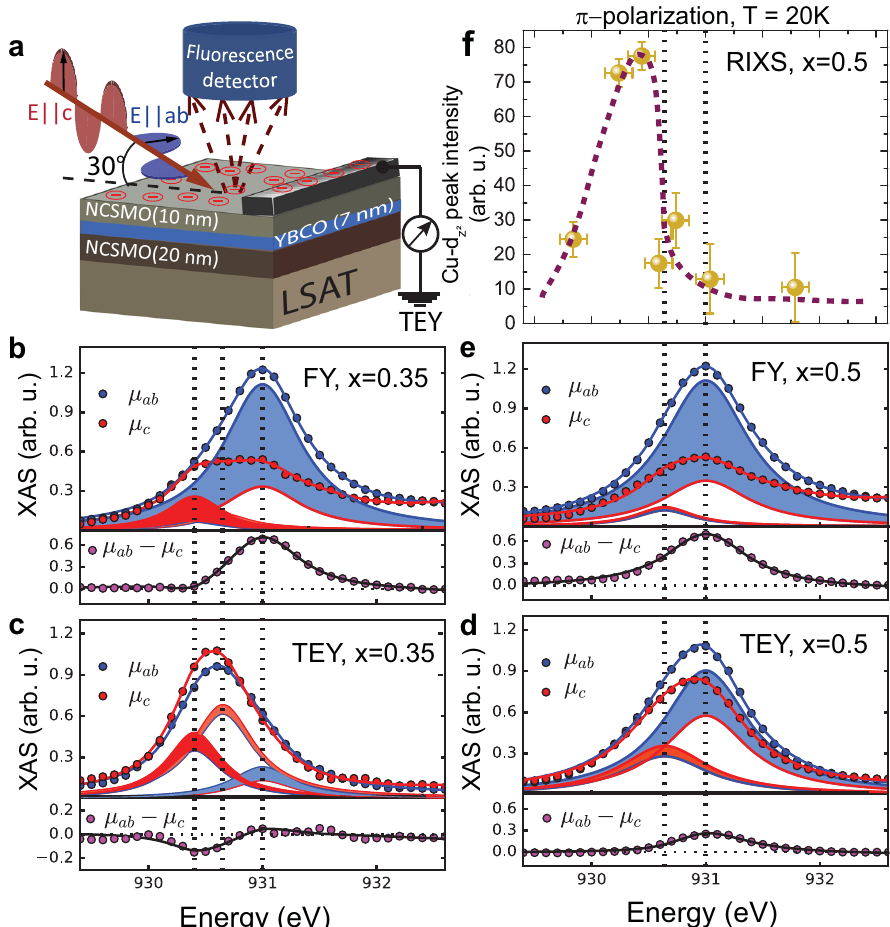
Fig. 4 Charge transfer and orbital reconstruction probed with XAS. a Schematic of the setup for measuring XAS in FY and TEY modes. b – e Comparison of the XAS spectra at the Cu L 3 -edge at 20 K and their X-ray linear dichroism (XLD) for NYN trilayers with x = 0.35 and x = 0.5. The FY spectra in ( b ) and ( e ) represent the response of all Cu ions whereas the TEY spectra in ( c ) and ( d ) are governed by the interfacial Cu ions. Solid symbols show the experimental data and solid lines are fi tted Lorentzian functions. The peak at 931 eV arises from the bulk-like Cu ions whereas the peaks at 930.3 and 930.6 eV are attributed to the interfacial Cu ions. The redshift of the latter with respect to the bulk-like resonance is due to the transfer of electrons across the NCSMO/YBCO interface. The sign of the XLD of the peaks is shown by the colored shading: when μ ab > μ c ( μ ab < μ c ) the difference is shaded blue (red). The spectra reveal that the charge transfer and the orbital reconstruction are considerably stronger at x = 0.35 than at x = 0.5. f Evolution of the intensity in π -polarization of the Bragg peak in the elastic RIXS signal at Q || ≈ 0.096 r.l.u. of the NYN trilayer with x = 0.5 as a function of the incident photon energy around the Cu L 3 -edge. It shows that the maximum occurs at a much lower energy than the one of the corresponding FY-XAS signal and even slightly below the one in the TEY-XAS (see panel ( e )). The propagation of uncertainty were calculated from the results of the fi tting using standard procedures (ref. 39